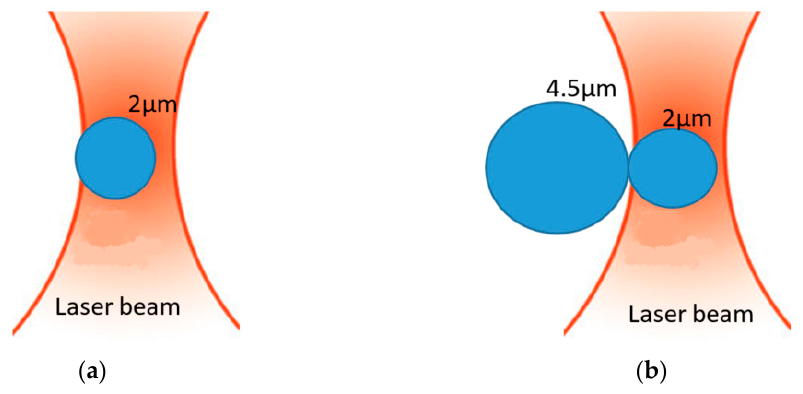
Figure 2. Illustration of different forces in competition: ( a ) 2 µm silica bead trapped and ( b ) system of a silica bead of 2 µm diameter stuck to one of 4.5 µm.